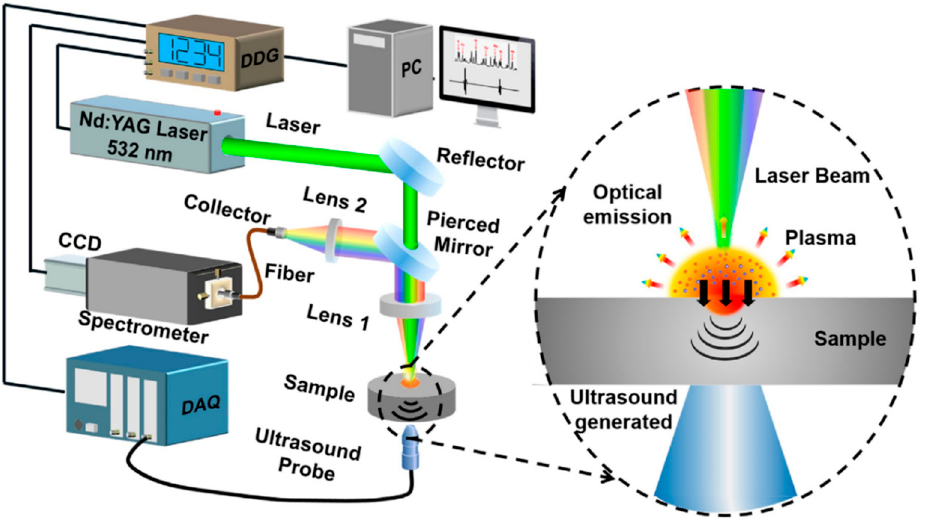
Figure 12. A picture of the LOUD process [28].